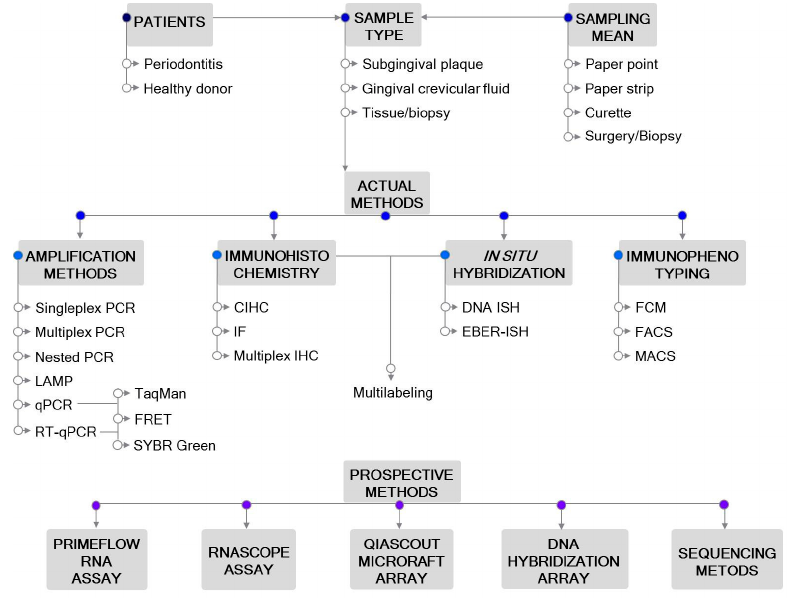
Figure 1. Outline of the methodological approaches for Epstein–Barr virus (EBV) detection in periodontitis. Actual and prospective methods are listed. Abbreviations: CIHC, chromogenic im- munohistochemistry; EBER—EBV-encoded RNA; FACS—fluorescence-activated cell sorting; FCM— flow cytometry; FRET—fluorescence resonance energy transfer; IF—immunofluorescent detection; IHC—immunohistochemistry; ISH— in situ hybridization; LAMP—loop-mediated isothermal ampli- fication; MACS—magnetic-activated cell sorting; PCR—polymerase chain reaction; qPCR—real-time quantitative PCR; RT-qPCR—reverse transcription